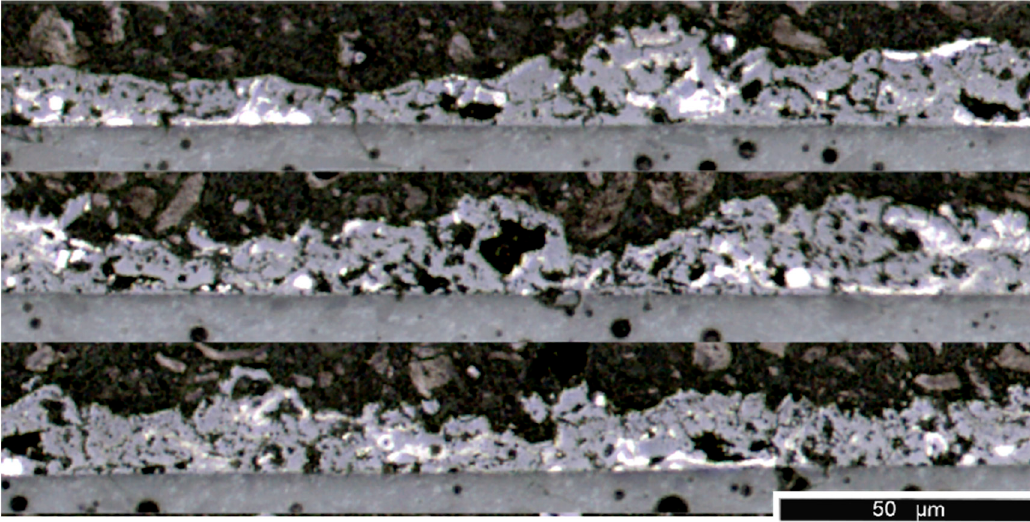
Figure 6. A composite optical image of the film after ablation on three separate cross-sections of film.